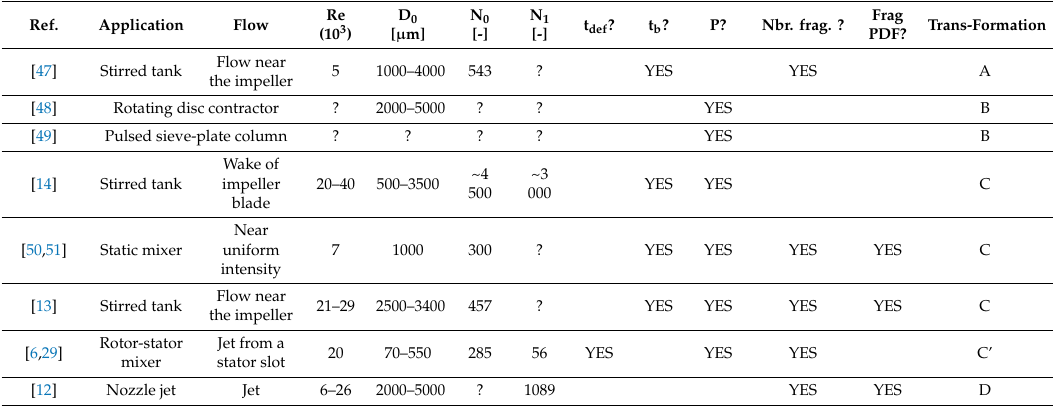
Table 1. Summary of the single drop breakup experiments that have attempted to measure the breakup